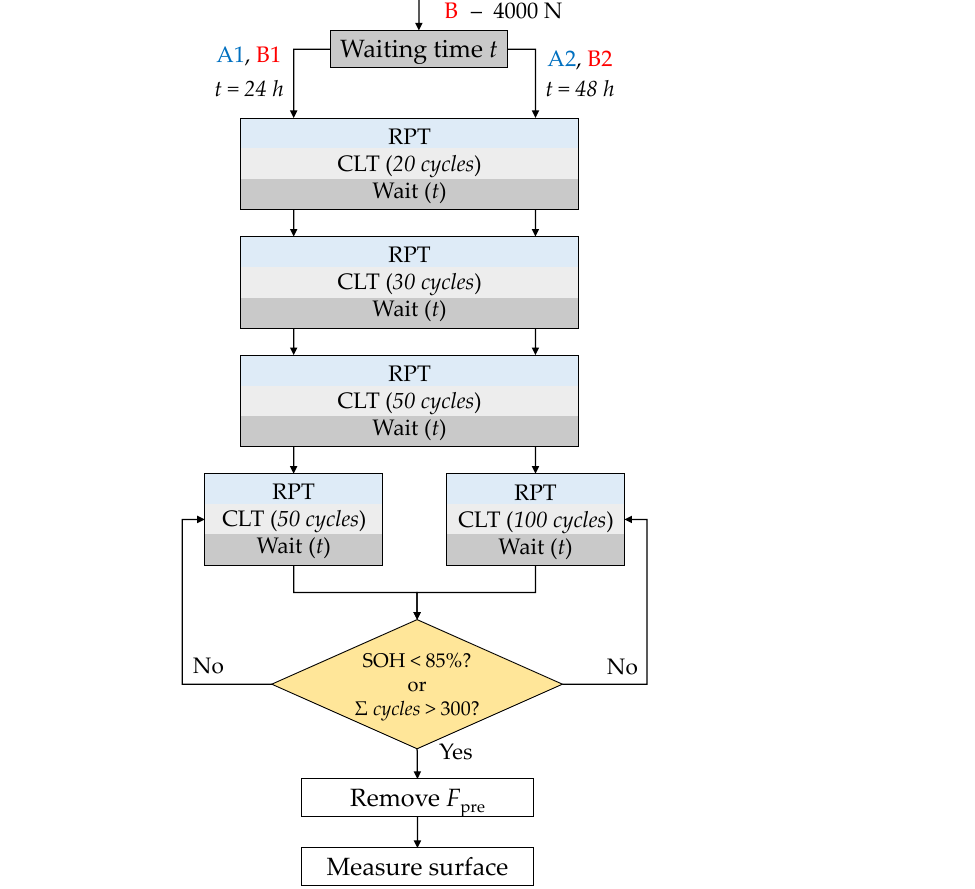
Figure 3. Aging procedure with RPT, CLT and wait phase with repetition until either 300 cycles or 85% SOH was